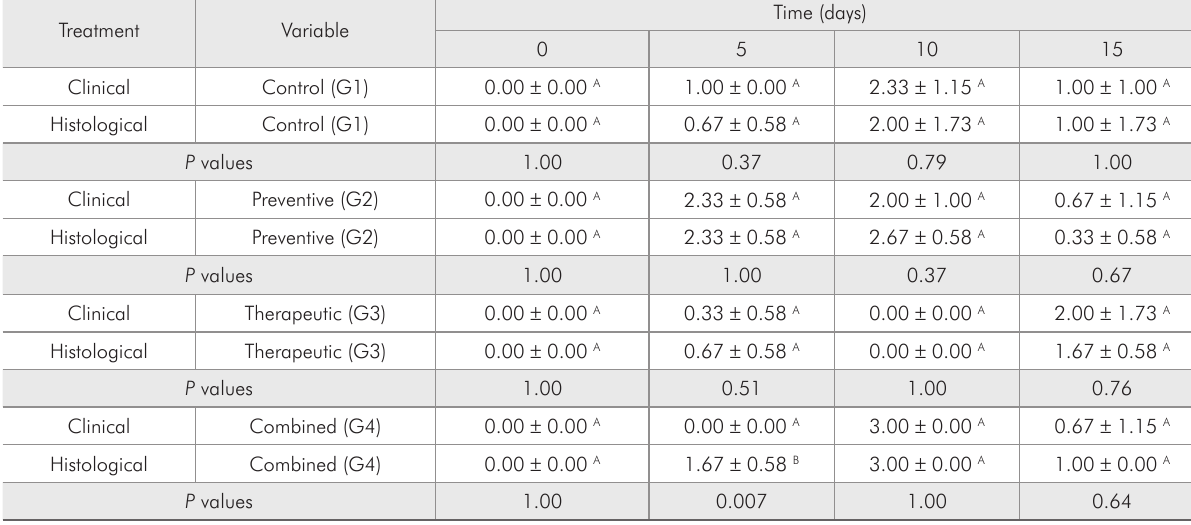
Table 4 - Comparisons of the clinical and histopathological